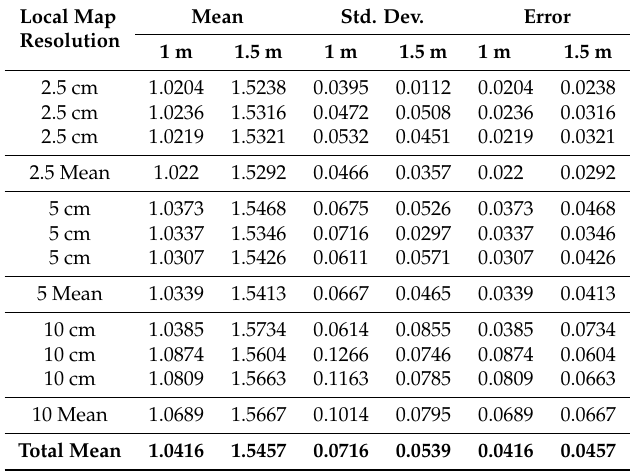
Table 1. Box distance shown in map and local map resolution experiment results. Experiment done with box distance 1 m and 1.5 m. Results in